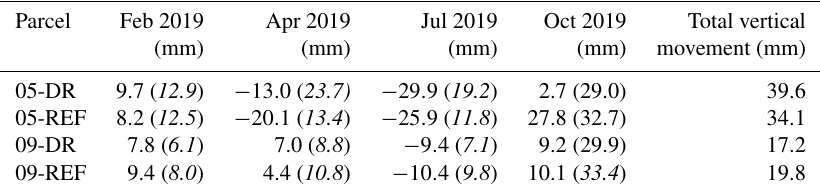
Table 1. Average vertical movement relative to T0 (November 2018; n = 114). Standard deviation in ( italic ). Total vertical movement for a specific parcel = max rise – max